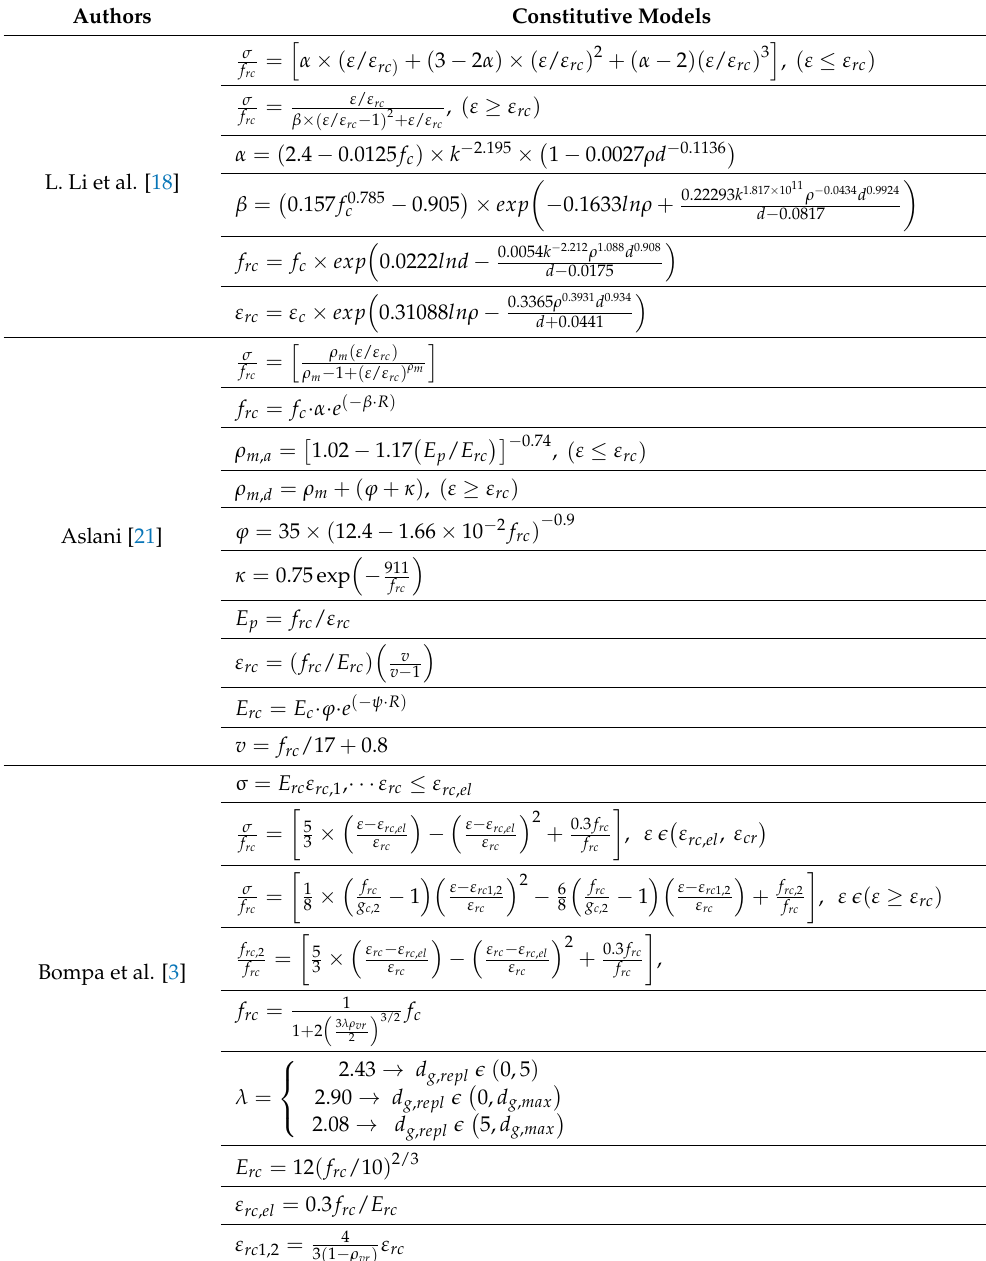
Table 2. Constitutive models for rubberized